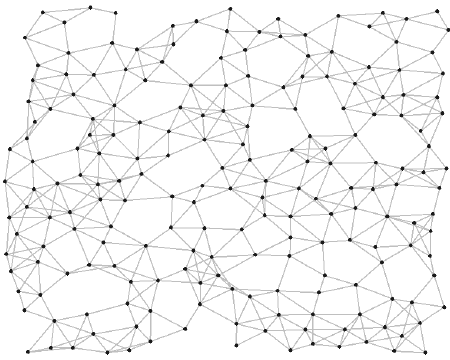
Figure 8. A random topology of 200 nodes.